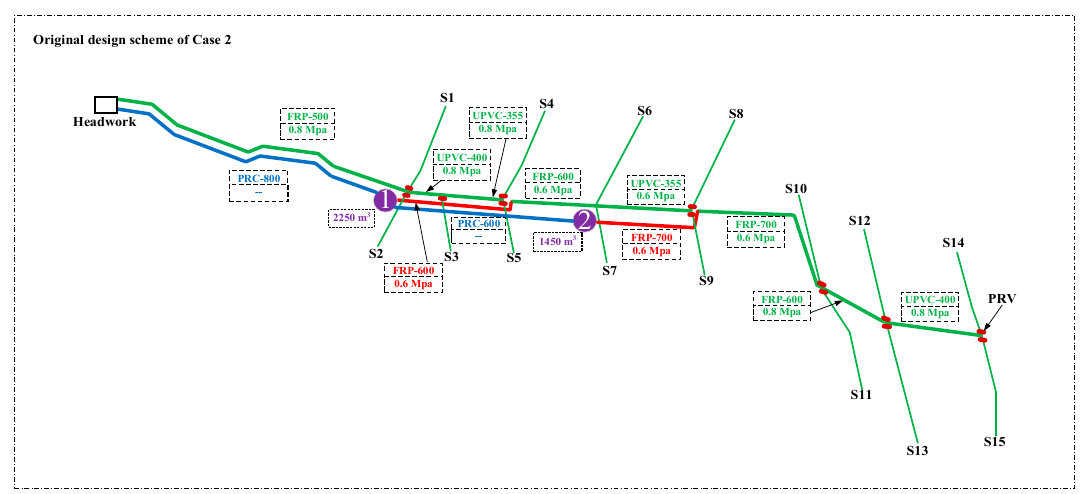
Figure 5. Design schemes with the ( a ) empirical method and ( b , c , d ) proposed methods for Case 1.